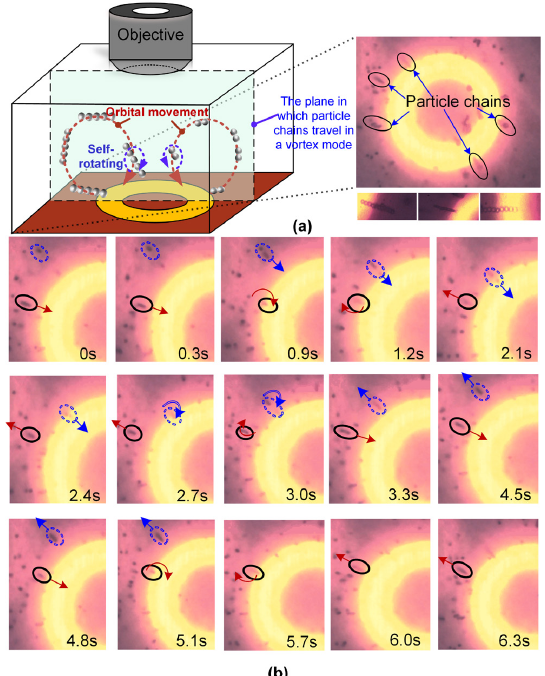
Figure 8. Optically induced ACEO flow assisted rotation of self-assembled microparticle chains at AC voltage of 20 V pp and 480 kHz. ( a ) Schematic description of the resultant motion consisting of self-rotation and orbital movement of particle chains in OET device. ( b ) Experimental snapshots of movement of particle chains at a series of time instants. The microparticles have a diameter of 4 μm. Arrows indicate the directions of orbital movements of particle chains in each snapshot. The time unit is second (s).